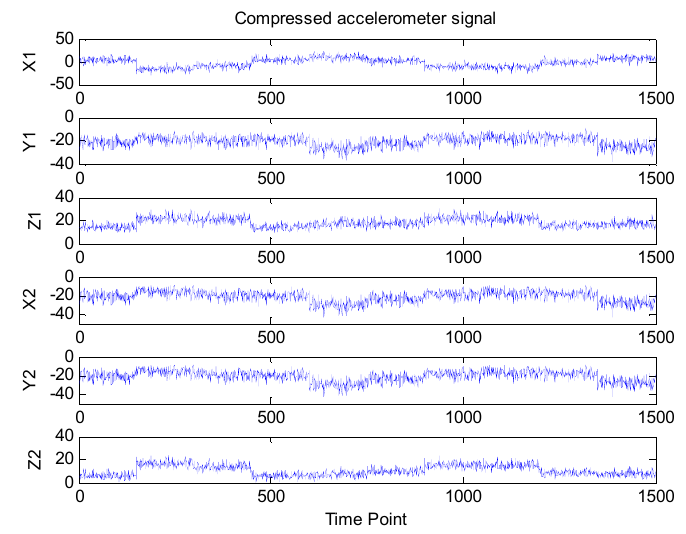
Figure 5. Compressed accelerometer signals.